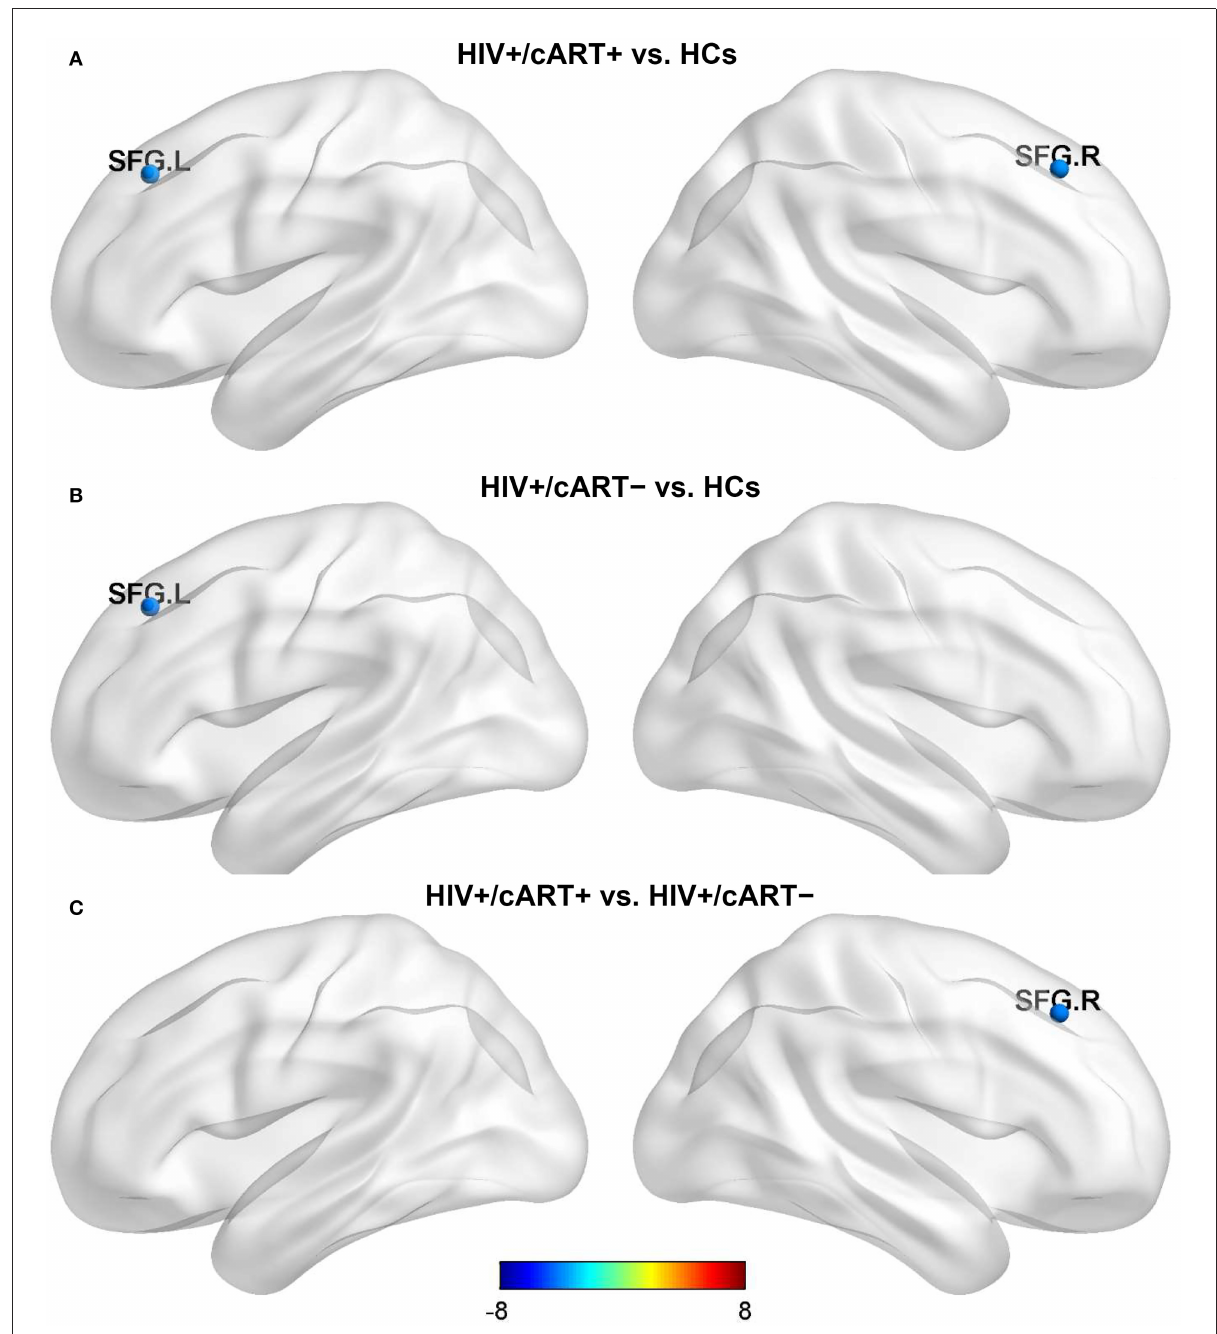
FIGURE1 Between-group results in regional nodal metrics-Nlp. The color bar scales represent the t value of Nlp difference between groups, a positive t value represents the Nlp of the former group is higher than the latter, and a negative value represents a decrease (presented in blue). (A) HIV + /cART + < HCs. (B) HIV + /cART– < HCs. (C) HIV + /cART + < HIV + /cART–. Nlp, the average of the shortest-path length from a node to any other node in the network; HCs, healthy controls; SFG, superior frontal gyrus; L, left; R,